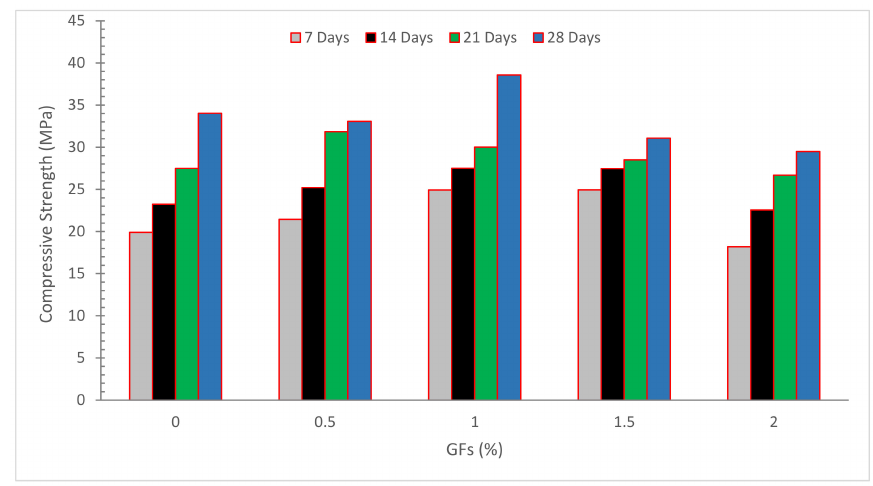
Figure 3. Compressive strength: Data source